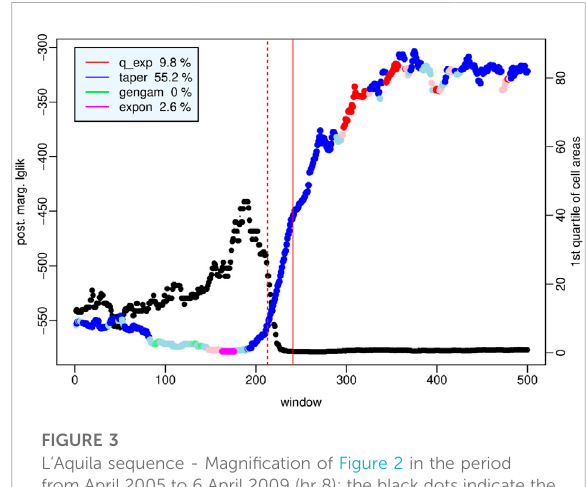
FIGURE 2 L ’ Aquila sequence - Posterior marginal log-likelihood of the probability distribution of Voronoi cell area that fi ts better than the other distributions to the dataset of each time window. The red vertical lines indicate the mainshock (solid line) and the M w 4 30 March earthquake (dashed line) respectively.